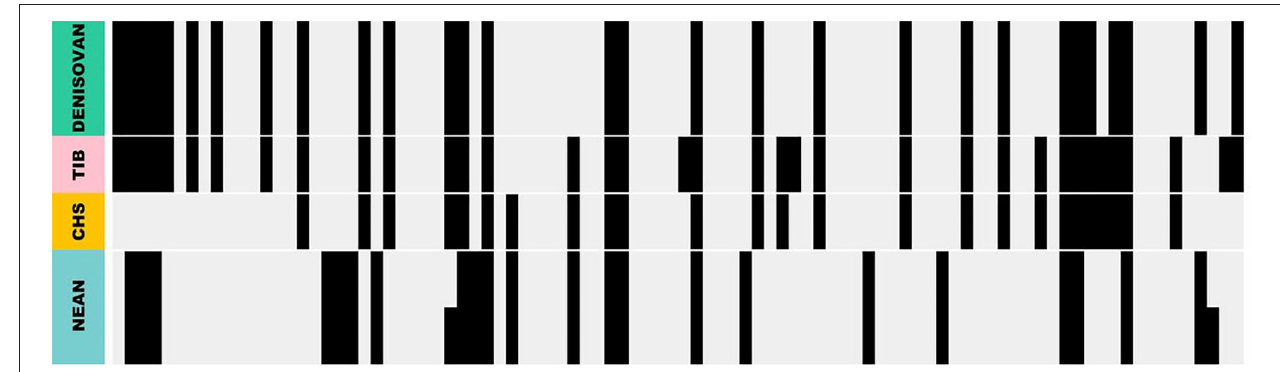
FIGURE 1 | Comparison with Denisovan and Neanderthal haplotypes. Each column represents a single nucleotide polymorphism (SNP). The first two rows are the two Denisovan haplotypes (in green), followed by the Tibetan (TIB) most common haplotype (in pink), the modern human haplotype in the 1,000 Genomes Project dataset that exhibits the closest match to the Tibetan haplotype [in yellow, Han Chinese (CHS)], and the two Neanderthal (NEAN) haplotypes (in blue). Derived (nonancestal) nucleotide states are shown in black. At any given site, a nucleotide state is considered derived if it differs from the corresponding state in the orthologous chimpanzee sequence, and it is considered ancestral if it matches the state in chimpanzee. Reproduced from Huerta-Sánchez and Casey (Huerta-Sánchez and Casey, 2015) with